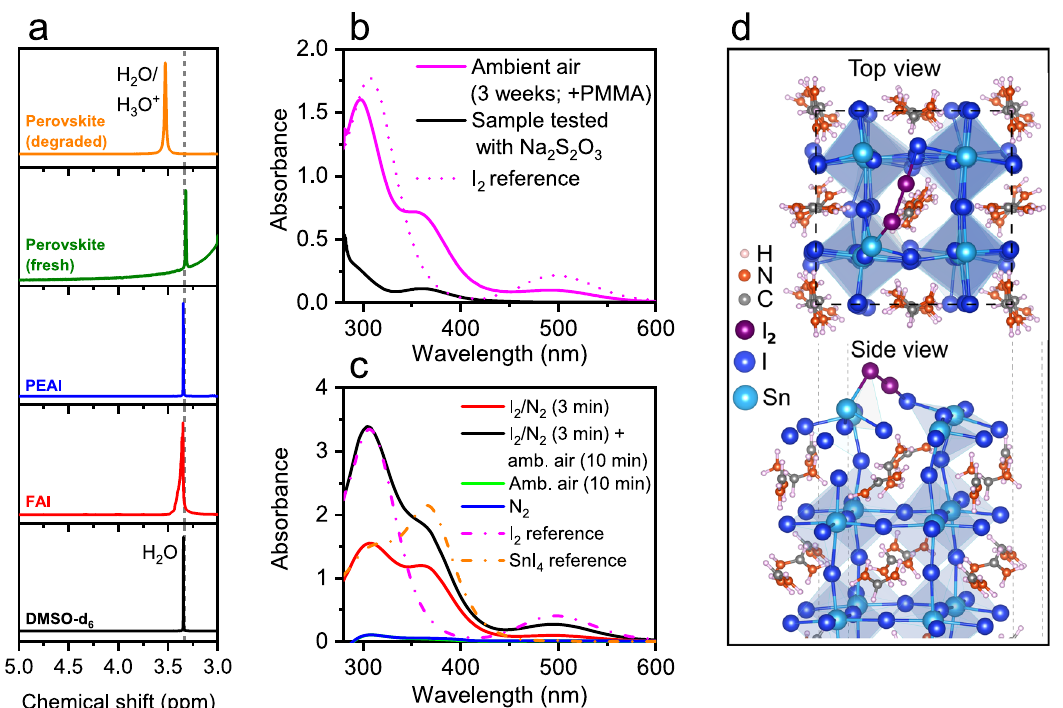
Fig. 4 Evolution of tin (IV) iodide to iodine and Sn perovskite oxidation by iodine. a Up fi eld 1 H-NMR spectra of DMSO-d 6 , FAI, PEAI, fresh (PEA) 0.2 (FA) 0.8 SnI 3 and (PEA) 0.2 (FA) 0.8 SnI 3 aged for 24 h in ambient air. b UV – Visible spectra of degradation products extracted in toluene (3 mL) from a PMMA-coated (PEA) 0.2 (FA) 0.8 SnI 3 thin- fi lm fully aged in ambient air for 3 weeks, the same solution after Na 2 S 2 O 3 addition and I 2 reference solution (dotted line) c UV – Visible spectra of degradation products extracted in toluene (3 mL) from (PEA) 0.2 (FA) 0.8 SnI 3 thin fi lms aged under different conditions (indicated in legend) and SnI 4 and I 2 reference solutions (dashed lines). d Top and side views of the structural arrangement of an adsorbed I 2 molecule (purple) on the (001) surface of FASnI 3 (from DFT